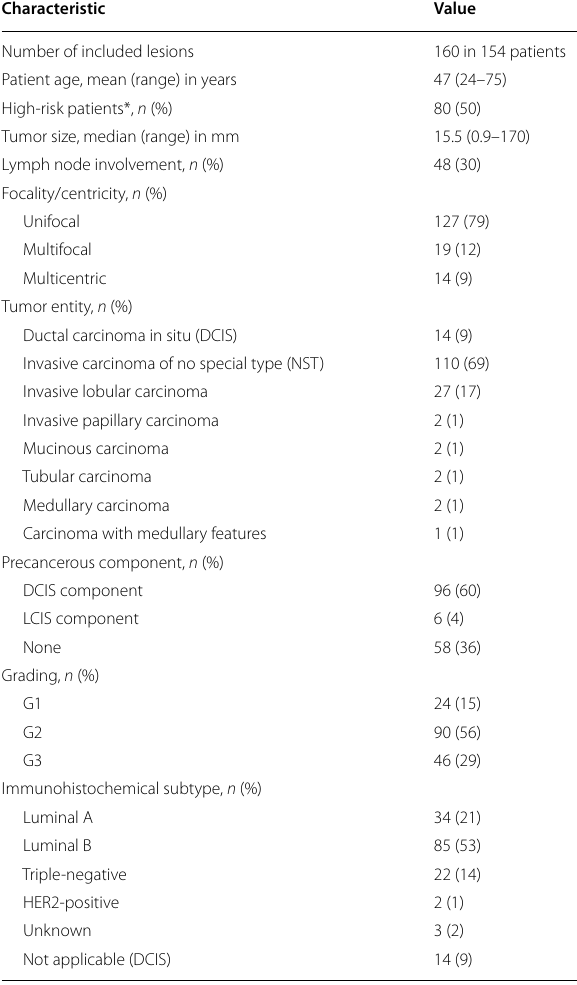
Table 2 Demographic and histopathological characterization of the study population